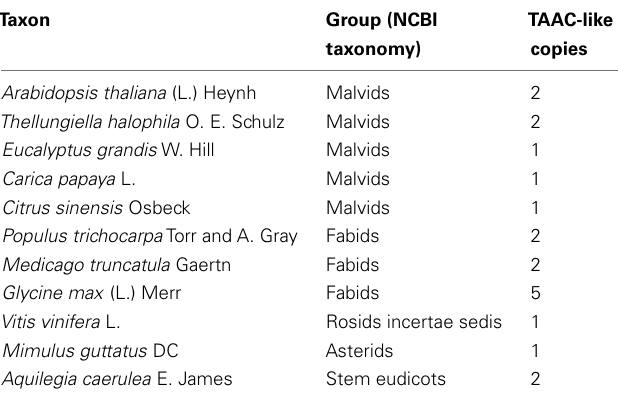
Table 1 | Copy number ofTAAC-like proteins found in various eudicot